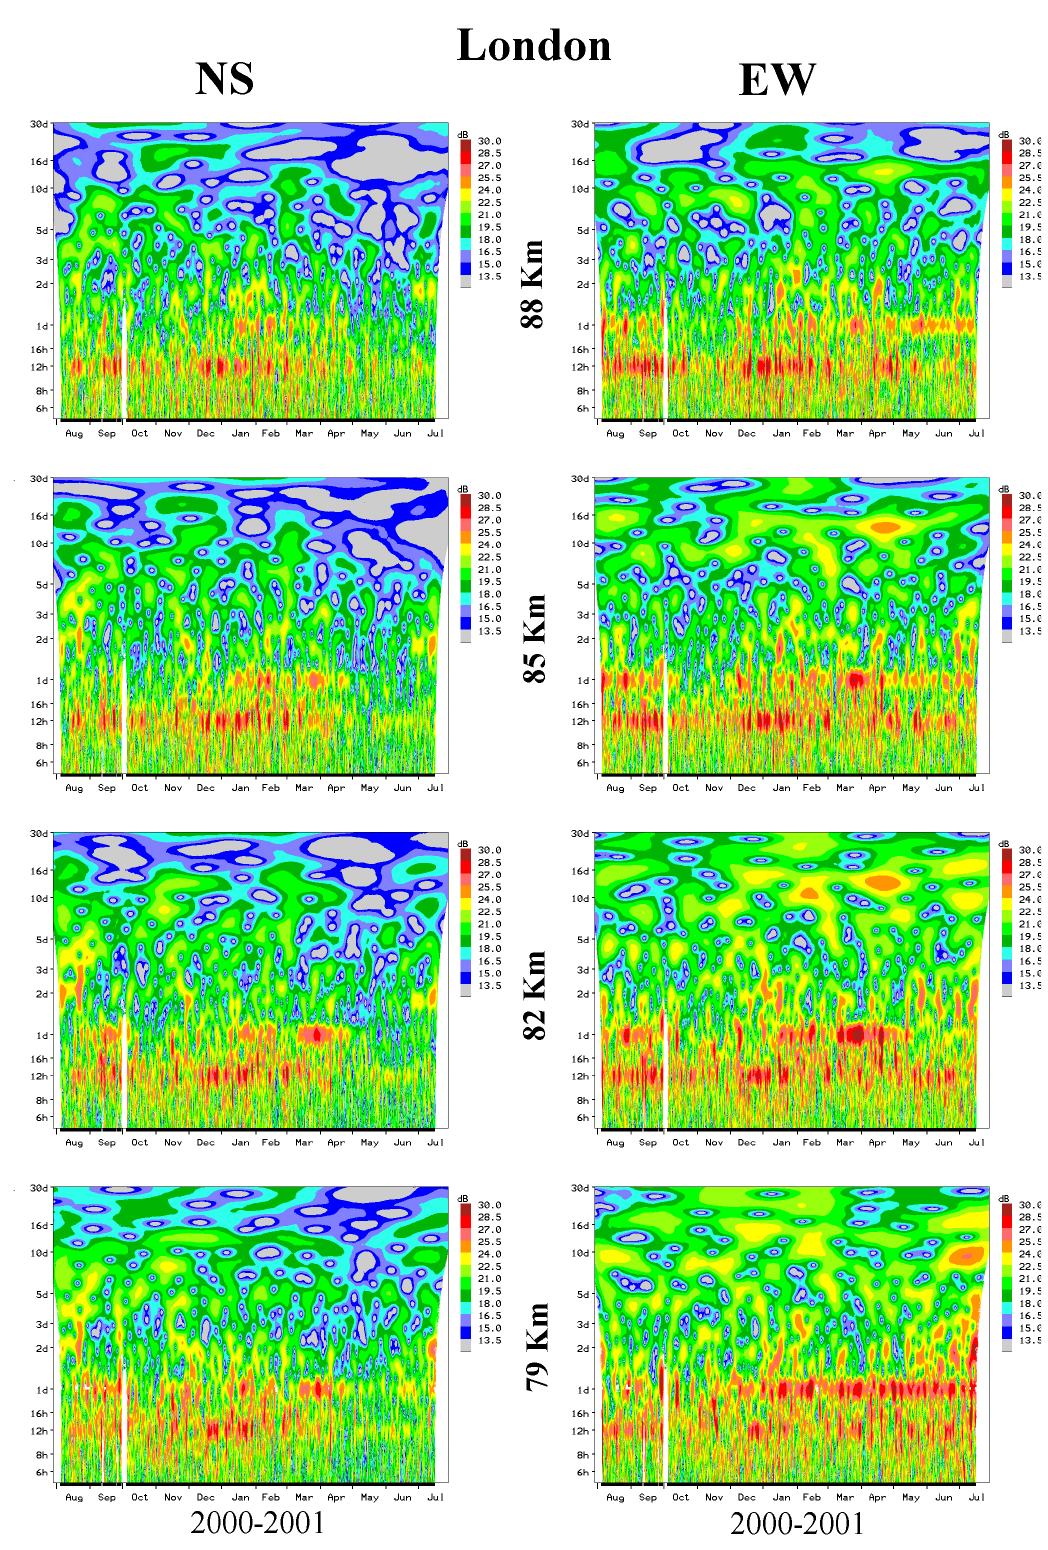
Fig. 1. Annual contours of wavelet intensities as functions of frequency and time for the zonal and meridional (EW, NS) components of the winds at four altitudes (79–88km): the location is London. Analysis details are provided in Sect.